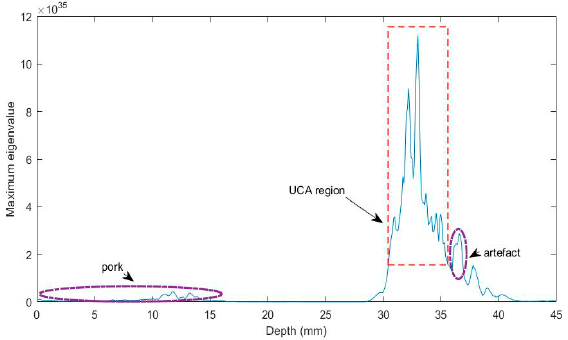
Figure 3. The maximum eigenvalue curve of different depths.